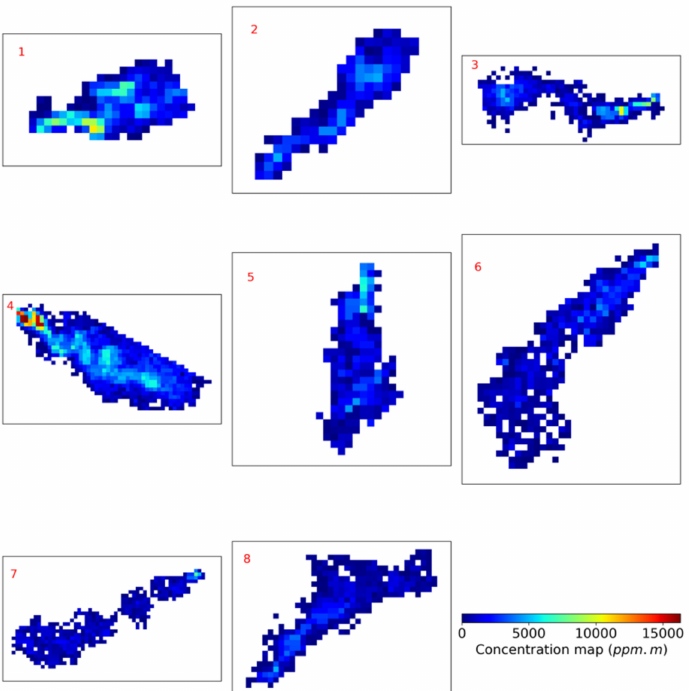
Figure A2. Concentration maps (in ppm · m) for the other plume detected. 1: 2020/04/19 source A. 2: